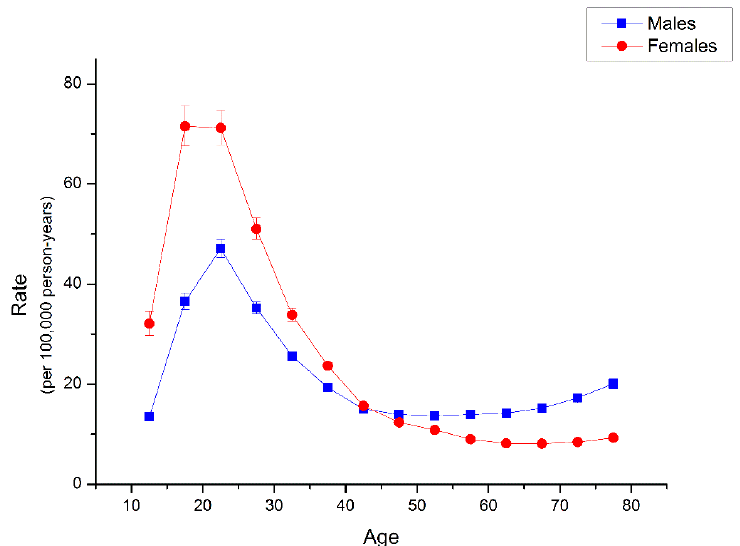
Figure 3. Longitudinal age curves of suicide rate by gender in China. Longitudinal age curves of the suicide rates (per 100,000 person-years) and the corresponding 95% confidence intervals (some of them were too narrow to show in the figure) by gender in China.